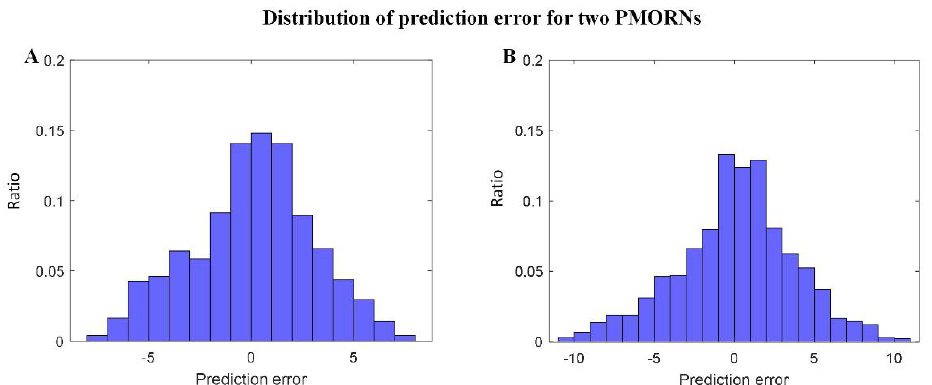
Figure 4. Distribution of the prediction error for the proposed models. ( A ) prediction error for ANN-based PMORN; ( B ) prediction error for SVR-based PMORN. The horizontal axis and vertical axis are the prediction error and the corresponding ratio for all the instances, respectively.